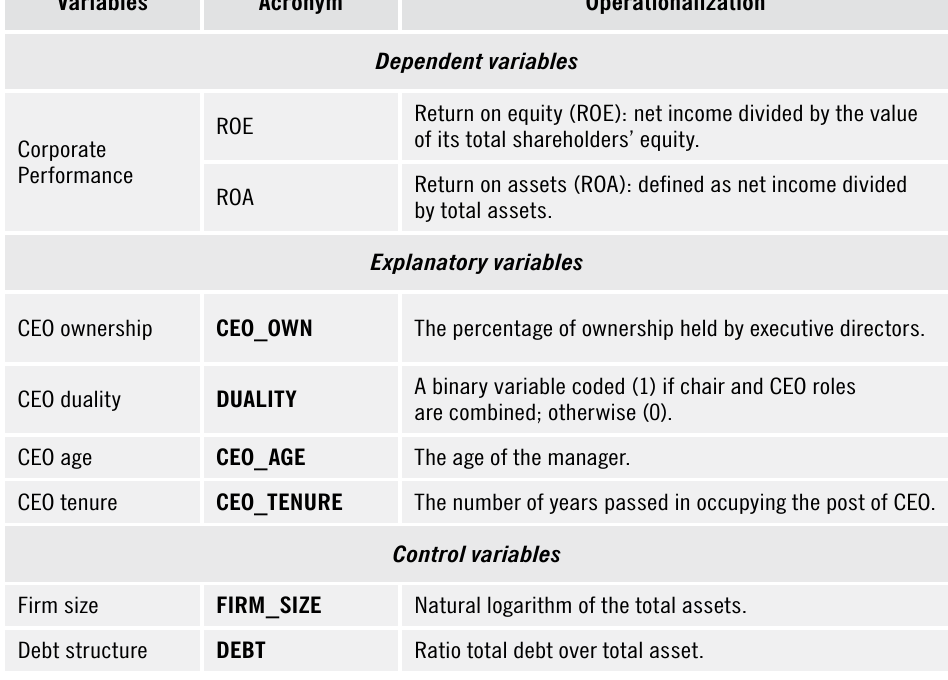
Table 3. Summary presentation of the variables of the study Variables Acronym